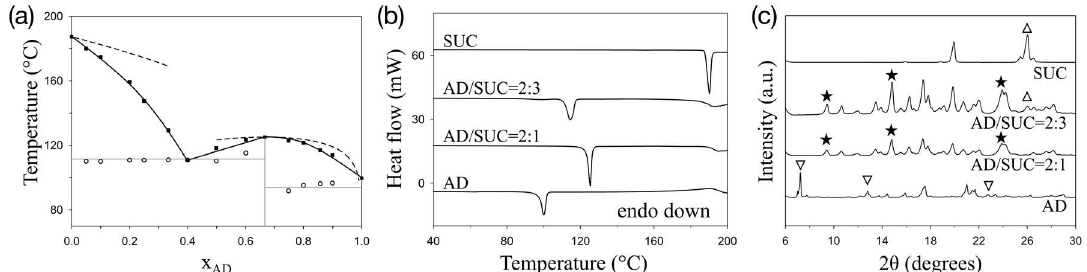
Figure 2. AD/SUC system: ( a ) melting diagram; ( b ) representative DSC thermograms; ( c ) representative XRD patterns. Top dashed lines in the melting diagram represent ideal liquidus lines. Some X-ray diffractions are marked as stars, triangles, and inverse triangles for cocrystal, SUC, and AD, respectively.